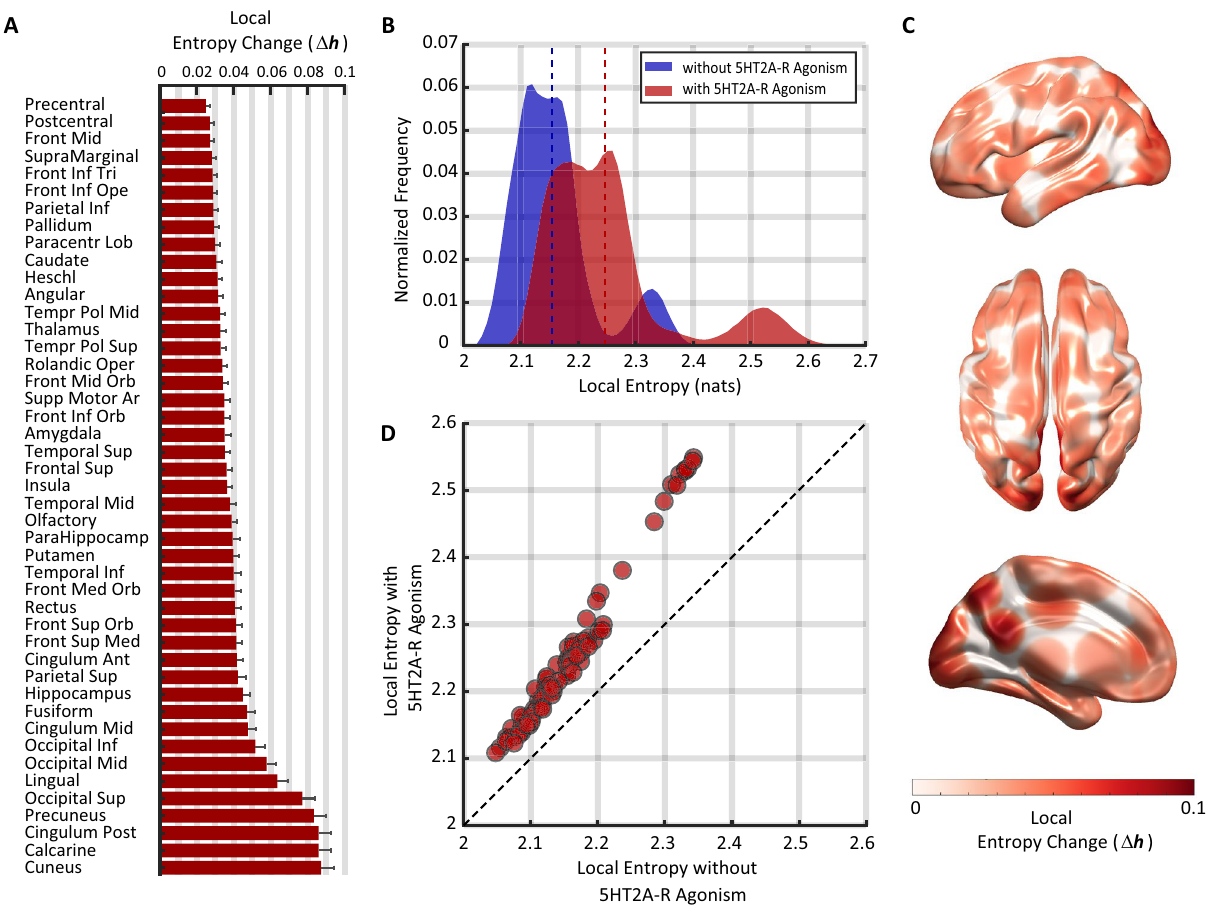
Figure 2. Linear heterogeneous increase of entropy following 5HT2A-R activation. ( A ) Effect of 5HT2A-R agonism on the local entropy each of region in the AAL atlas. See Supplementary Table 1 for abbreviations. Bars indicate the (bilateral) average relative change in local entropy, (cid:31) h n , and error bars indicate 1 standard deviation across 1000 simulations. ( B ) Histograms of local entropy values for the condition with (red) and without (blue) 5HT2A-R activation. 5HT2A-R activation increased both the average and the spread of the local entropy distribution. ( C ) Topographical map of entropy changes. Brain regions are coloured according to their (cid:31) h n values. ( D ) 5HT2A-R agonism changed the topographical distribution of entropy in linear manner. Each circle indicates the averages of each region across 1000 simulations.